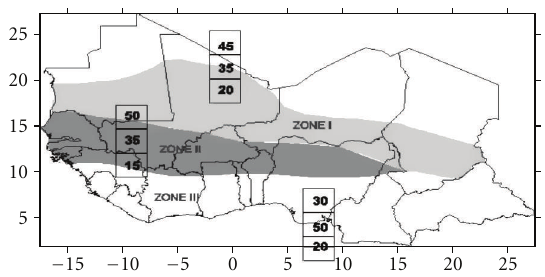
Figure 2: The 2008 PRESAO forecast: Probability forecast for precipitation over July-August-September (source: [25]).